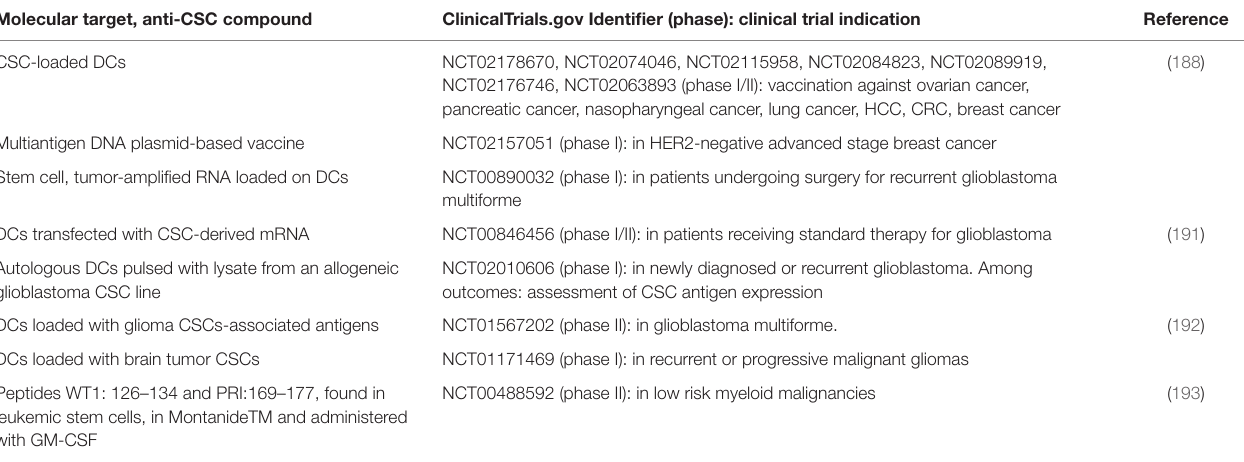
TABLe 6 | Anti-CSC vaccines. Molecular target, anti-CSC compound ClinicalTrials.gov identifier (phase): clinical trial